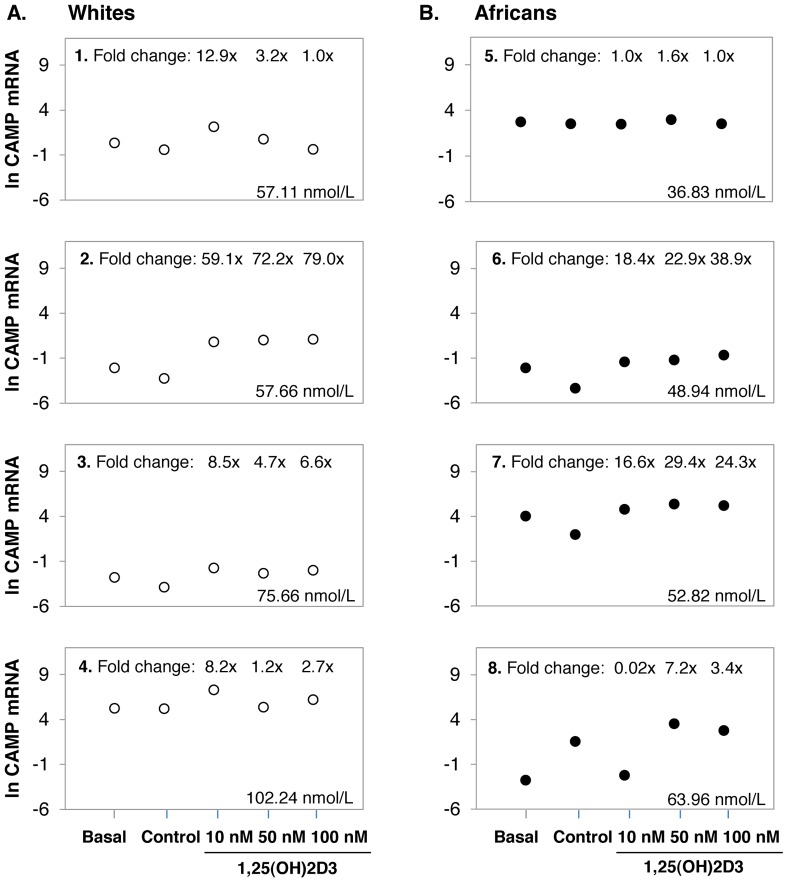
Individual-specific response to increasing in vitro 1,25(OH)2D3 supplementation is 25(OH)D3 status-independent.Dots illustrate the mean level of CAMP expression per individual for Whites (A, 1–4) and Africans (B, 5–8). The 25(OH)D3 status, as well as the 1,25(OH)2D3-mediated fold change in expression level relative to the control is shown for each individual (untransformed data). Gene expression was quantified in monocyte-macrophages from healthy individuals using RT-qPCR before (basal) and after 24 h of in vitro 1,25(OH)2D3 supplementation at increasing concentrations (10 nM, 50 nM, and 100 nM). Plasma 25(OH)D3 status was quantified using LC-MS. A trend towards higher CAMP level is present at 10 nM 1,25(OH)2D3 for Whites, while Africans showed marginally increased CAMP expression at 50 nM 1,25(OH)2D3 concentrations. No trend between plasma 25(OH)D3 status and in vitro response to increasing concentrations of 1,25(OH)2D3 is present.